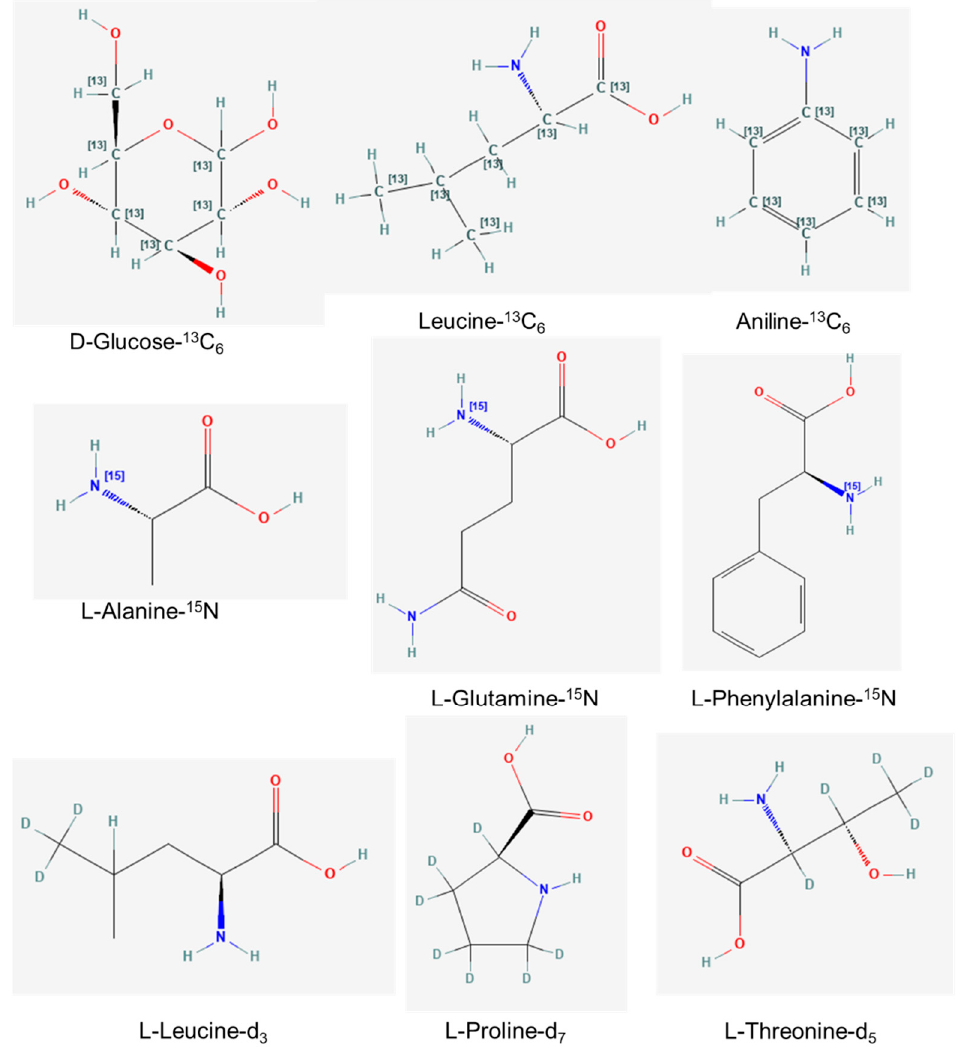
Figure 1. Examples of commercial stable isotope tracers of carbon ( 13 C), nitrogen ( 15 N), and deuter- ium ( 2 H).